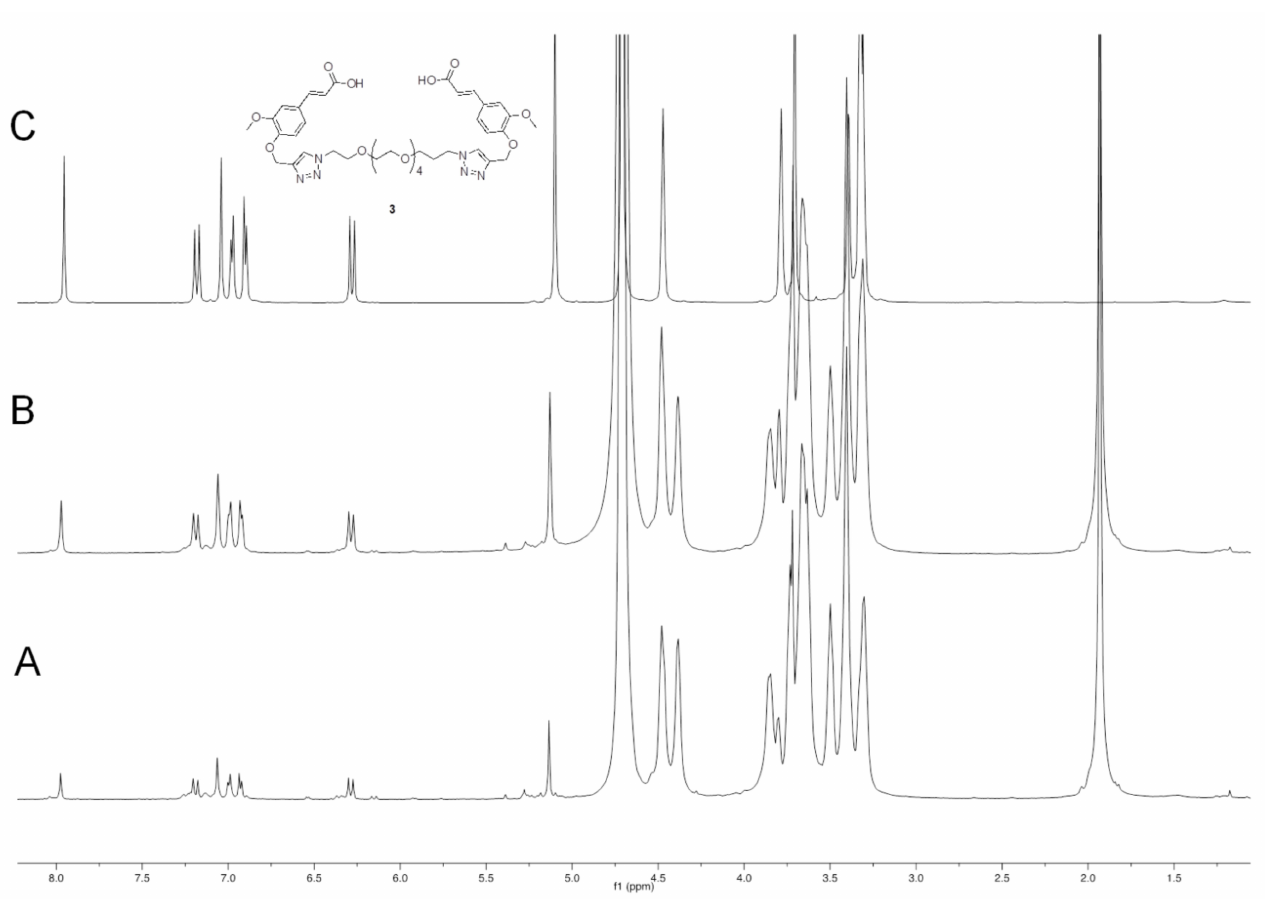
Figure 6. The comparison of 1 H NMR spectra obtained when a gel dispersion of HA(270)-FA-HEG- CL - 10 material in deuterated water was treated with sodium hydroxide at room temperature in an NMR tube for 24 h. ( A ): before the addition of compound 3 ; ( B ): immediately after addition of compound 3 ; ( C ): 1 H NMR spectrum of a solution of reference compound 3 in deuterated water containing